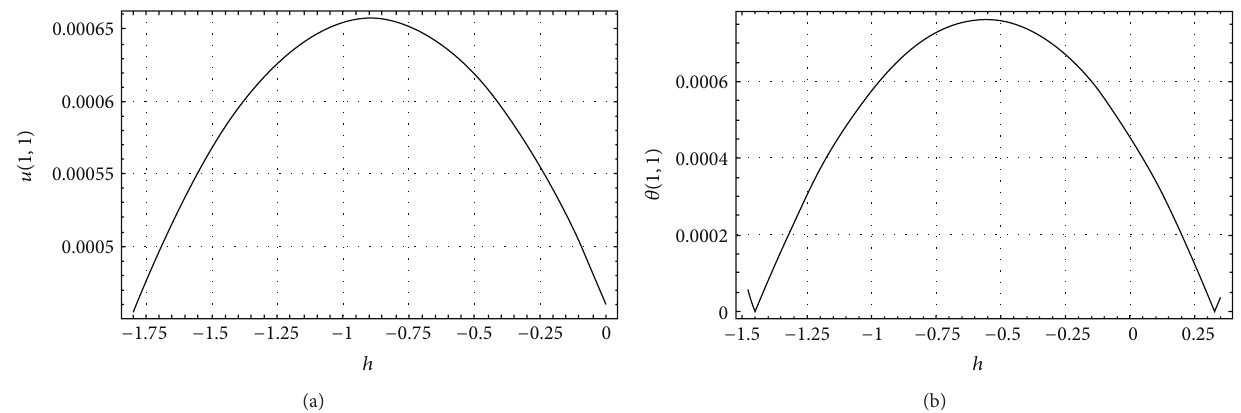
Figure 1: The ℎ -curve of the third-order approximate solutions of (14) when 𝑥 = 1.0 , 𝑡 = 1.0 ; for LS model when 𝜏 2 = 0 , 𝜏 1 = 1 , 𝛿 = 1 , = 0.2 , 𝜎 = 0.1 , Ω = 0.1 , and 𝜔 = 0.02 . 𝜎 1 2